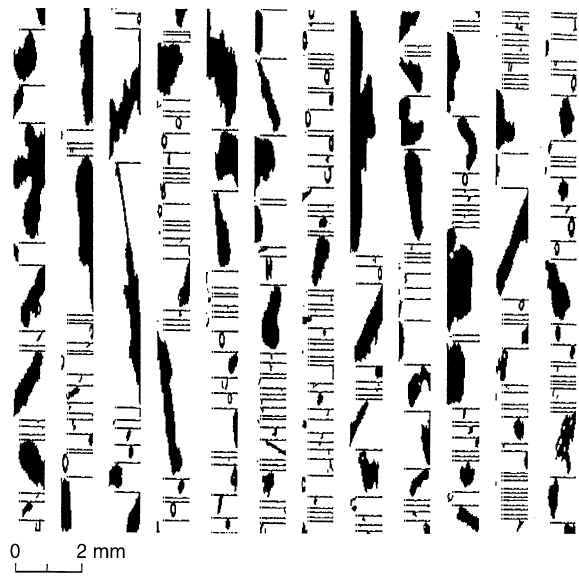
Fig. 10. Examples of ice-particle images measured by the 2D-C probe at the point B indicated in